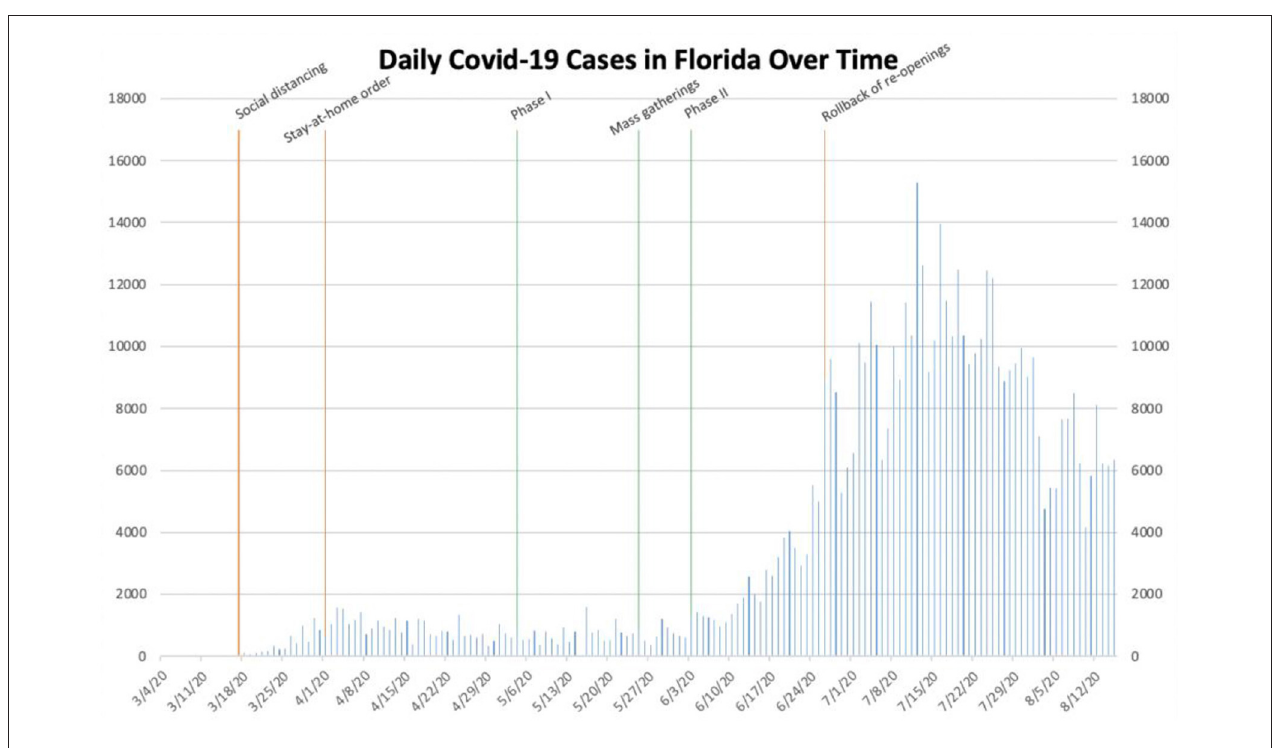
FIGURE 3 | Daily COVID-19 cases in